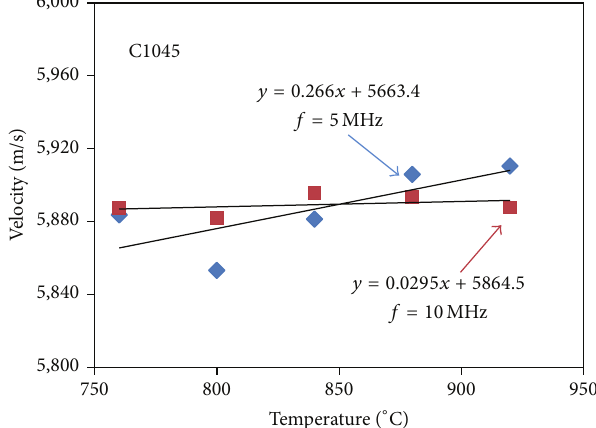
Figure 8: Velocity of samples at different heat treatment tempera- tures using 5 and 10MHz.